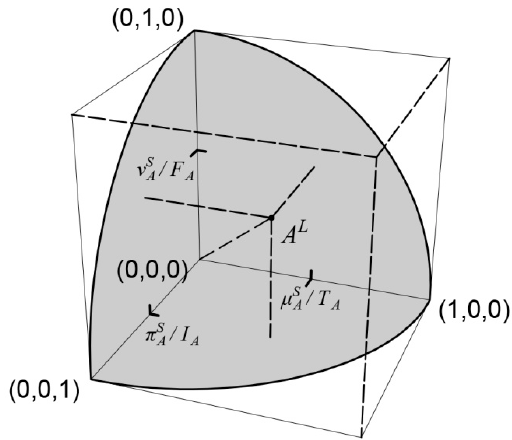
Figure 8. Interpretational cube of NS and interpretational space of SFS.